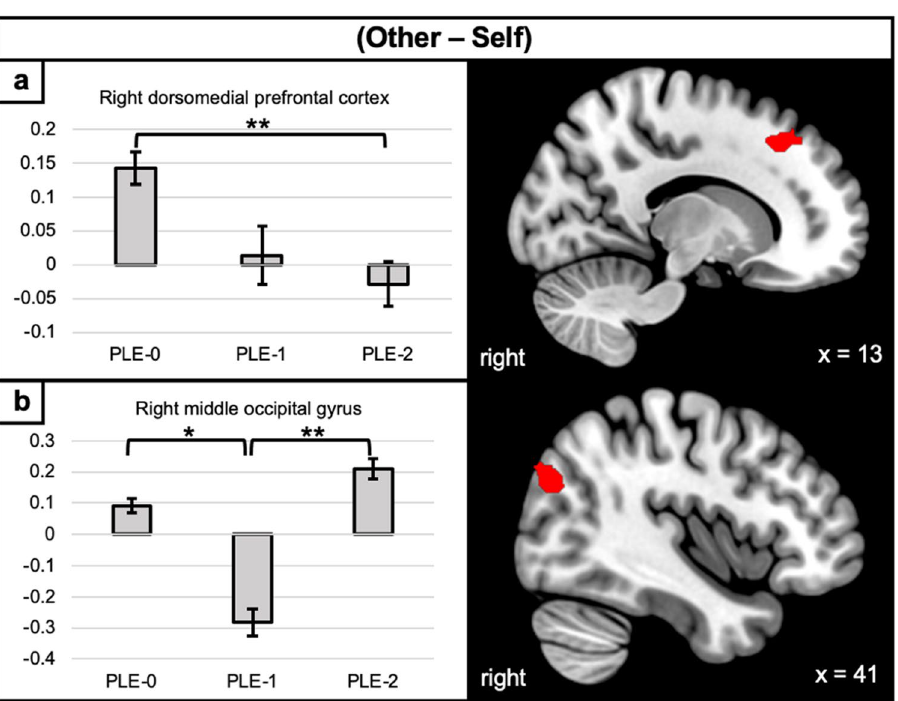
Figure 2. between-group differences in activation levels during the (Other—Self) contrast. Activation maps the clusters of between-group differences during the (Other—Self) contrast isolating the differentiation and integration of other- and self- related information. Error bars correspond to the standard error. PLE-0 = control trajectory; PLE-1 = decreasing trajectory; PLE-2 = increasing trajectory. *p < 0.005. **p <